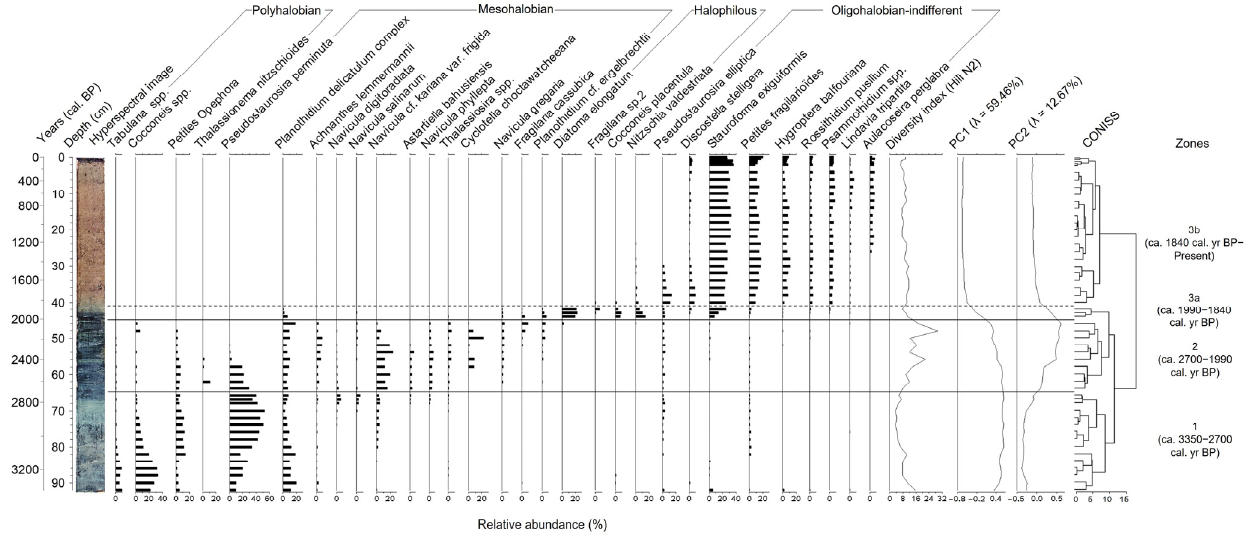
Figure 7. Relative abundance (%) of the most common diatoms ( ≥ 5% in at least one level), diversity index, sample coordinates along the two main PCA axes, and biostratigraphic zones (CONISS) of Evilik Lake.